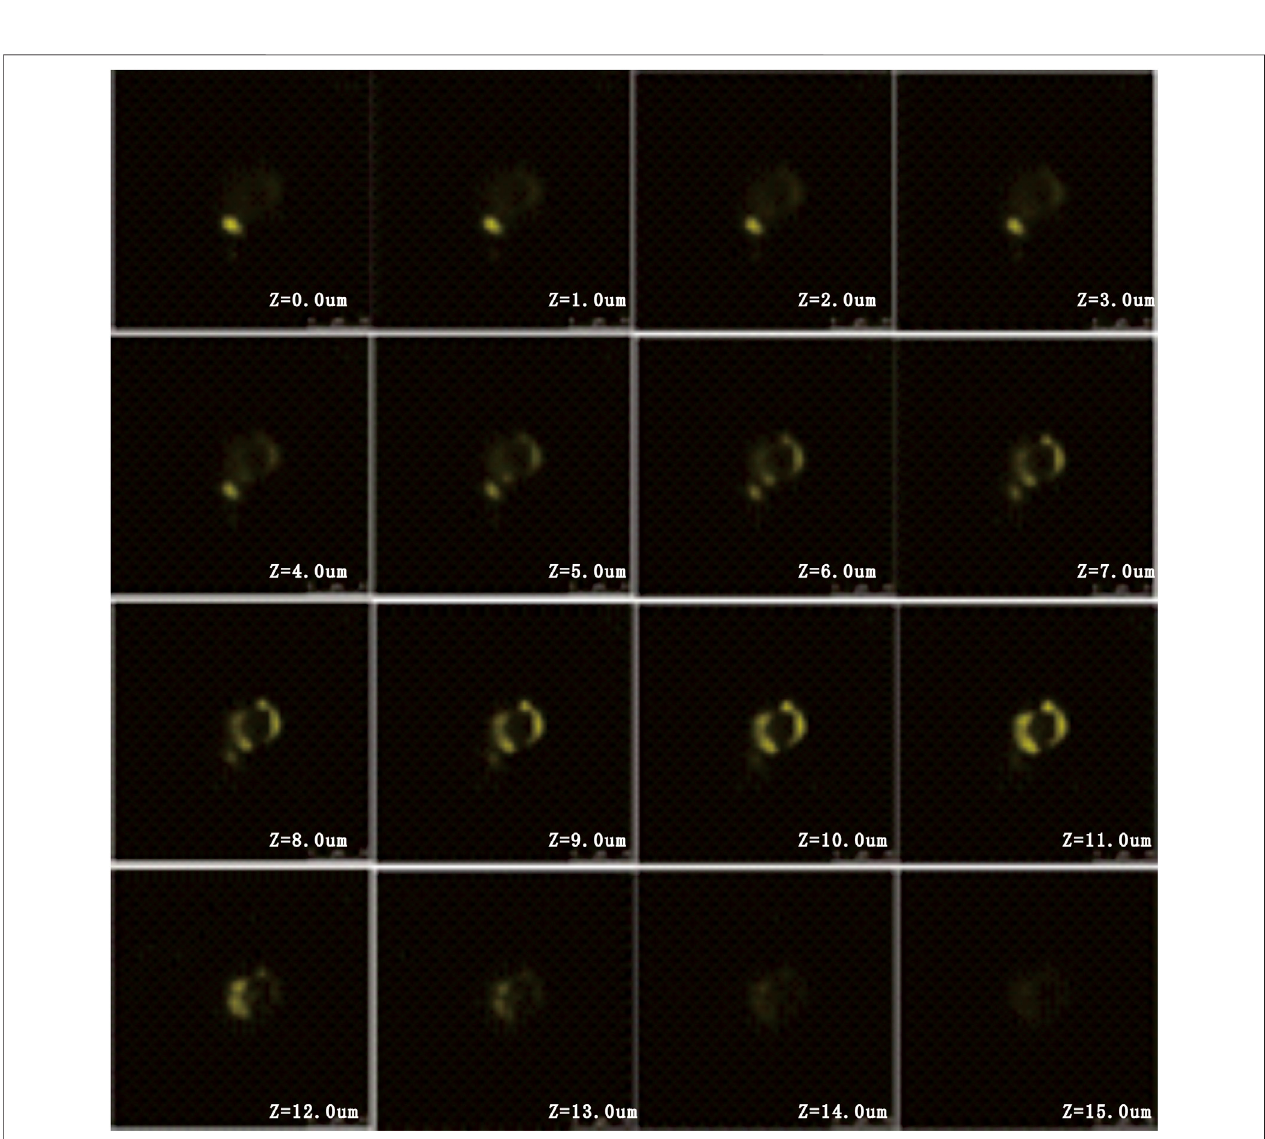
Frontiers in Earth Science |